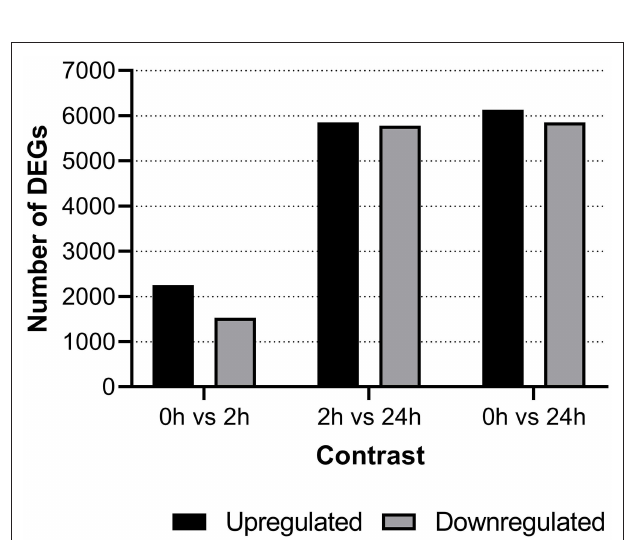
FIGURE 2 | Number of differentially expressed genes shown for each of the three time points i.e., negative control (0-hps) vs. recombinant interferon gamma stimulation for 2h (2-hps) or 24h (24-hps). Horizontal line bars show upregulated genes while downregulated genes are shown using diagonal